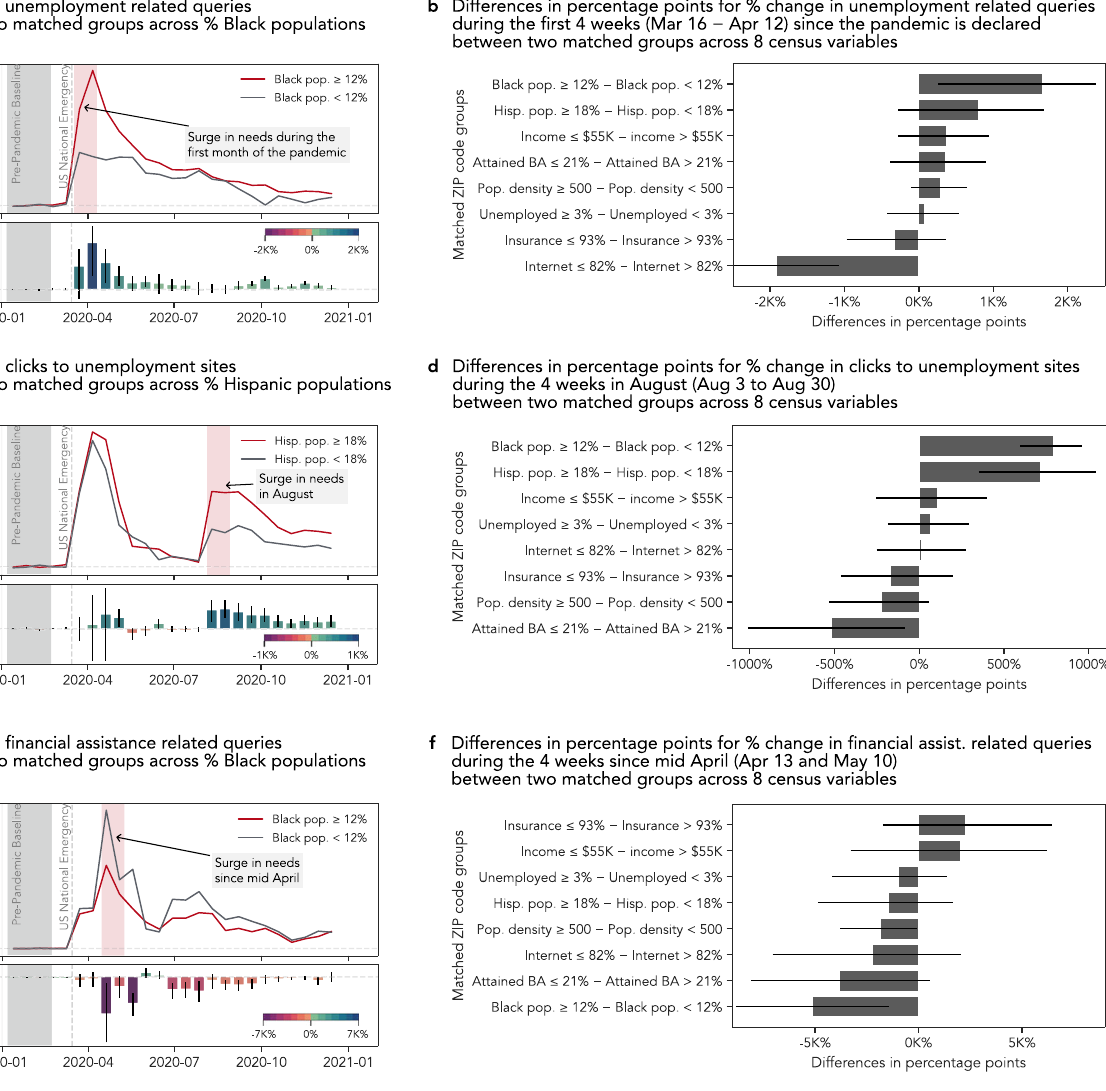
Fig. 2 | Disparities in online economic assistance access. a The surge in unemployment-related search queries peaks during the fi rst month since the declaration of the pandemic and tapers off over the year 2020. During this fi rst month,ZIPcodeswithhigherproportionsofBlackresidents( ≥ 12%)haveexpressed up to 3,358% more unemployment-related queries while ZIP codes with lower proportions of Black residents (<12%) have expressed 1320% more. b Across the seven census variables, ZIP codes with higher proportions of Black or Hispanic residents and lower income populations experienced greater changes in unemployment-related queries during this fi rst month. c When we examine search queries that led to clicks in state unemployment sites, we see a second surge in August, with ZIP codes with higher proportions of Hispanic residents ( ≥ 18%) experiencing more than double the change in clicks in state unemployment sites compared to ZIP codes with lower proportions of Hispanic residents (<18%). d We